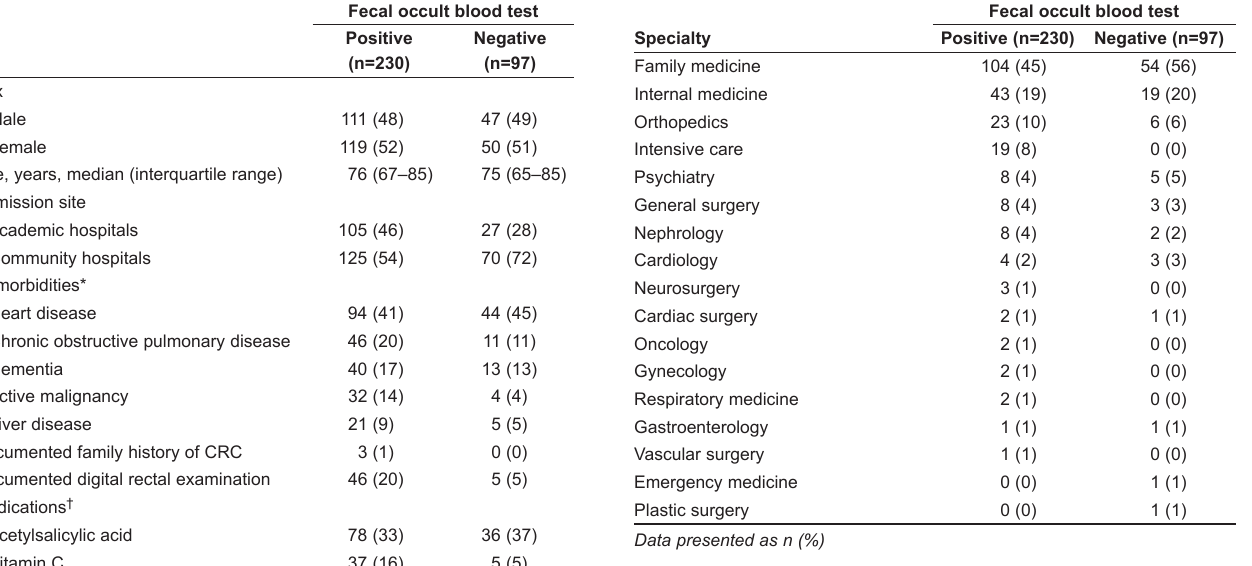
TAble 2 Medical specialty of the physician ordering fecal